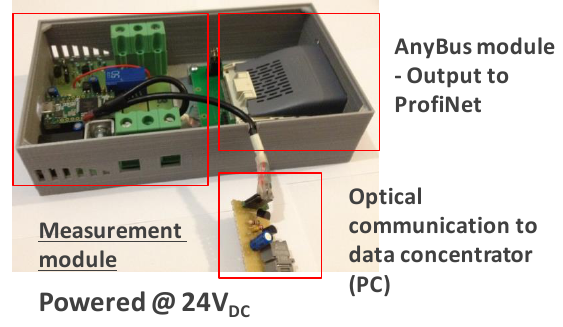
Fig. 7. Developed power measurement hardware testing prototype.